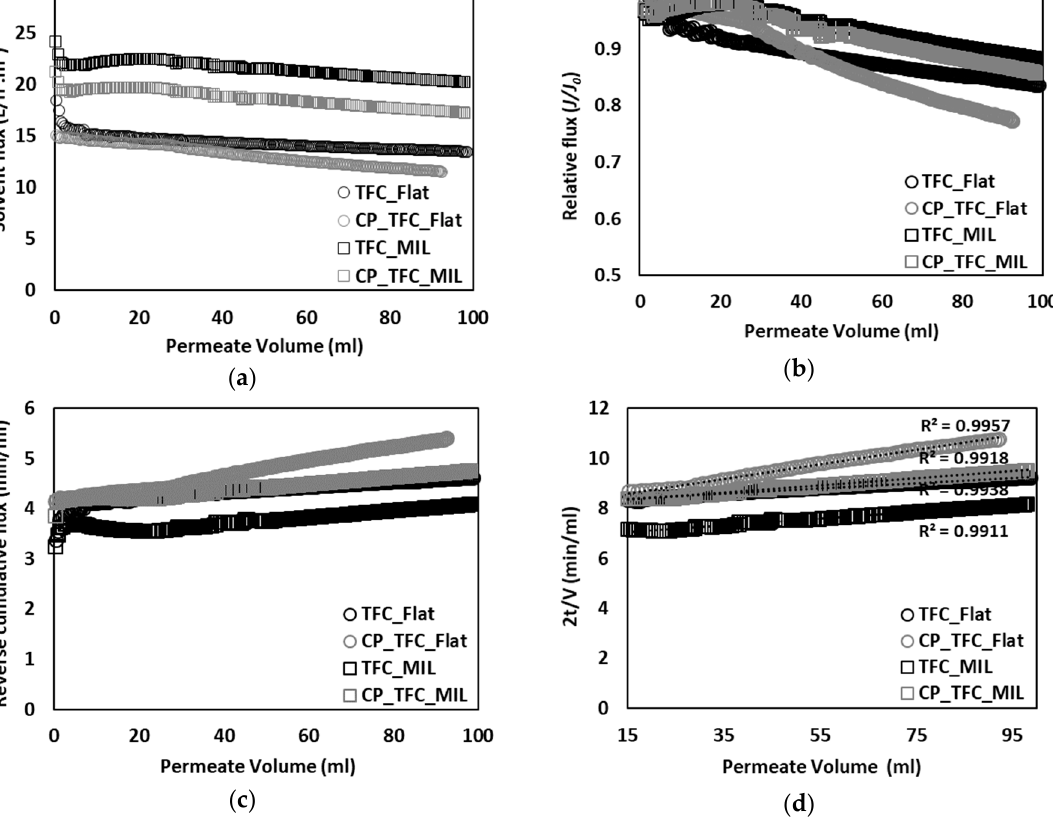
Figure 6. Performance curves for colloidal fouling of flat and micro-patterned membranes by silica nanoparticles (50 nm) in unstirred dead-end filtration conditions, with constant pressure (~17 bar) and ambient temperature (23–25 °C). The experiments were repeated at least two times, employing a virgin membrane for each; the relative error was <15%. ( a ) Solvent flux decline vs. permeate volume; ( b ) Relative flux decline vs. permeate volume; ( c ) Reverse cumulative flux vs. permeate volume; ( d ) Application of cake-layer filtration model to the experimental data.